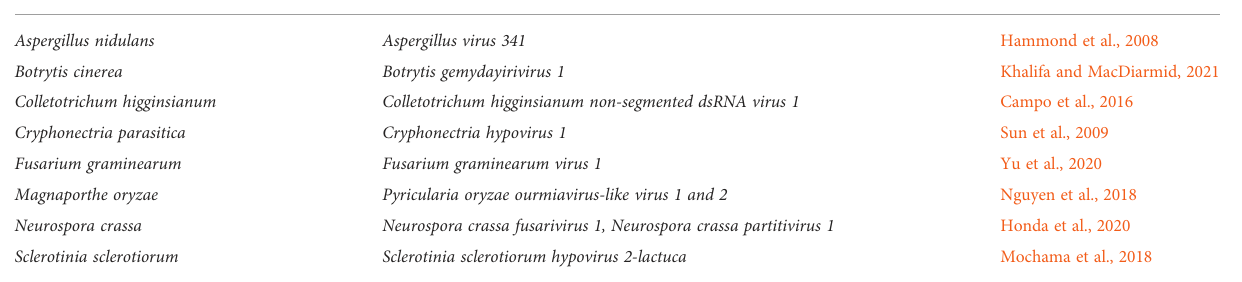
TABLE 1 Fungal RNA interference is an antiviral activity.